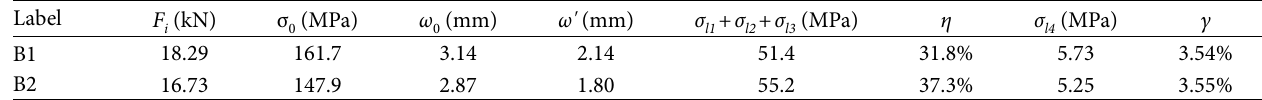
Table 6: Measurement and calculation for the prestress